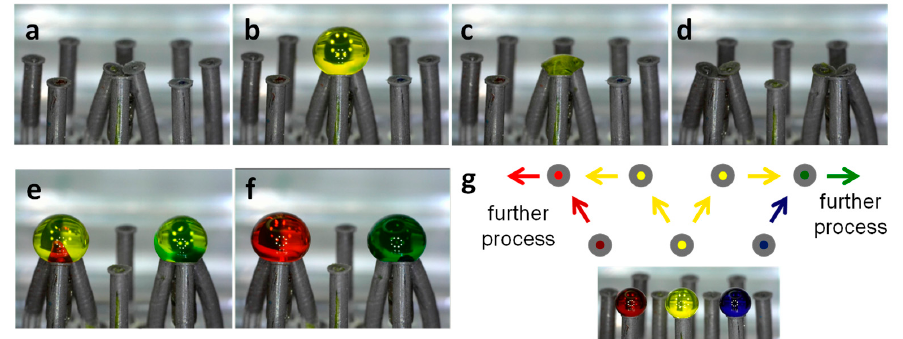
Figure 7. Splitting-recombination process. ( a ) First group of nozzles brought into contact. ( b ) Release of yellow solution and ( c ) split into the other two nozzles by suction. ( d ) Rearrangement of the magnets, two groups of nozzles ready for combination. ( e ) The two portions from the initial drop are released and then the mixing solutions red and blue, left and right, are simultaneously released. ( f ) The homogeneous mix is achieved in less than 2 s. ( g ) Sketch of the flows in this process.